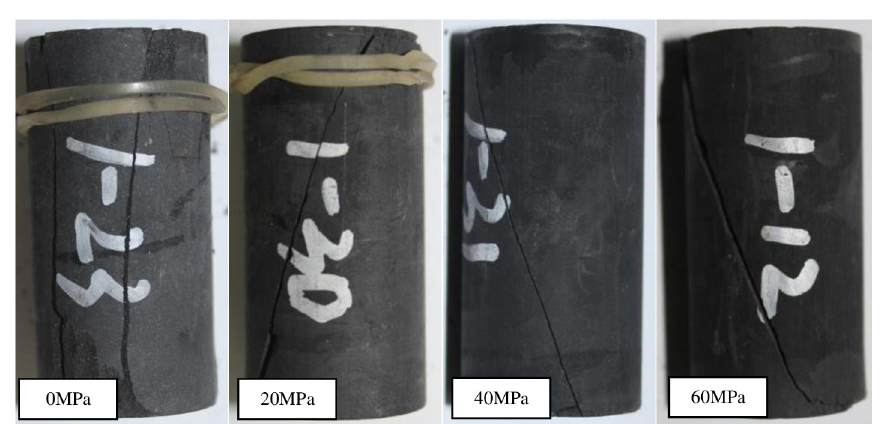
Fig 7. Fractured samples after conventional triaxial compression test.